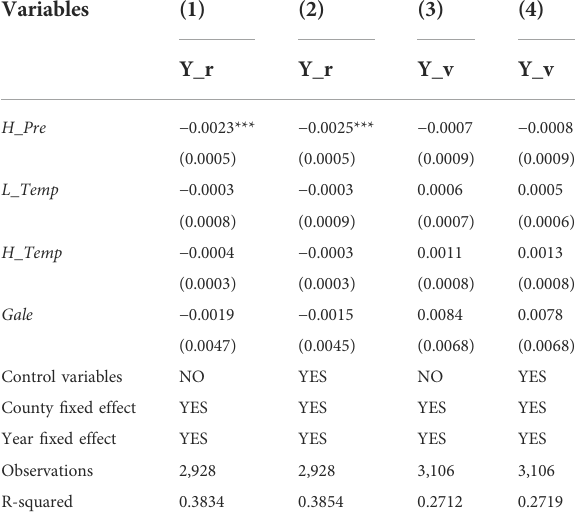
TABLE 2 The effects of meteorological factors on the per unit yield of